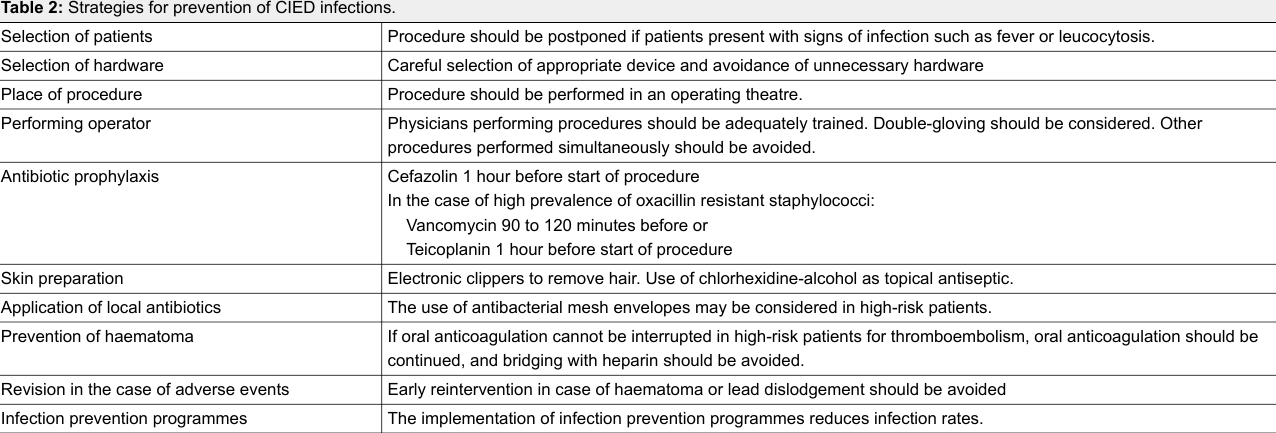
Table 2: Strategies for prevention of CIED infections.